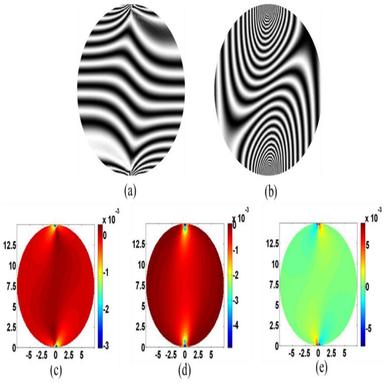
Fringe pattern of the displacement fields with rigid-body rotation along (a) the x axis and (b) the y axis, and strain fields (c) ɛxx, (d) ɛyy, and (e) xy of the simulation model.